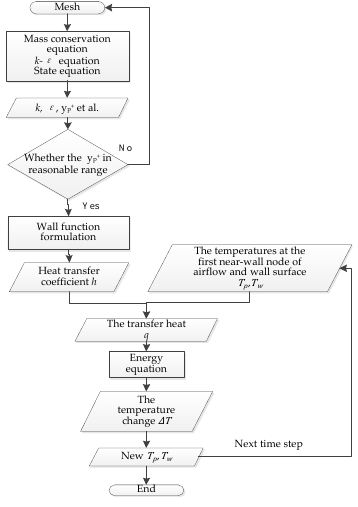
Figure 1. Flowchart of the coupling heat transfer calculation.